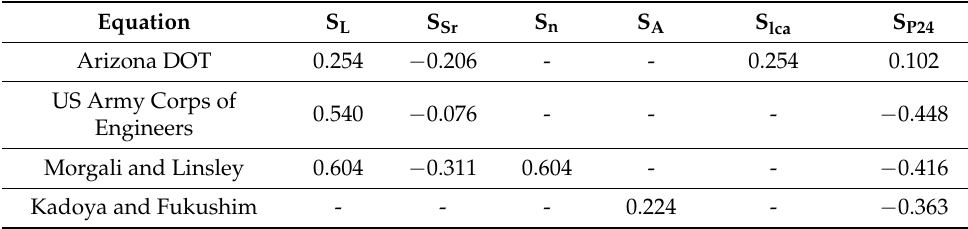
Table 9. Sensitivity coefficients of the methods based on P 24 (category